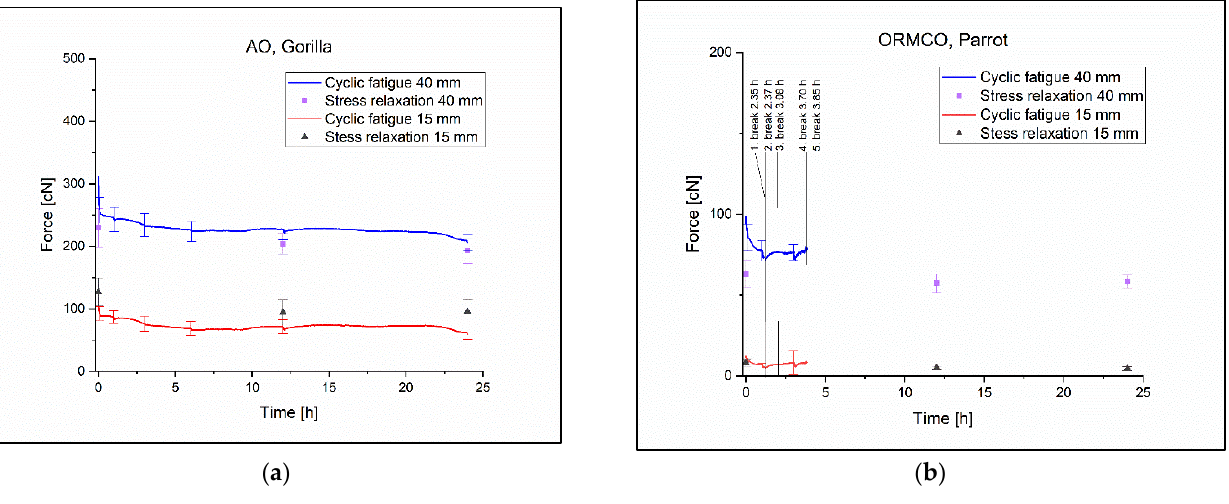
Figure 6. ( a ) The Gorilla ligature cyclic and relaxation diagram. ( b ) The Parrot ligature cyclic and relaxation diagram with the times of the torn specimens. Table 3. The cyclic fatigue tests’ Tukey statistics in case of Gorilla and Parrot ligatures. The orange color indicates the significant differences with 95% confidence interval. If the change is less than 5%, it is indicated in